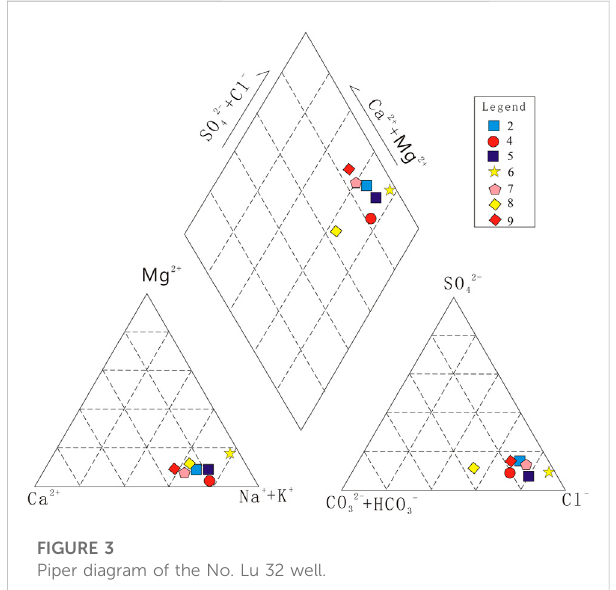
FIGURE 3 Piper diagram of the No. Lu 32 well.